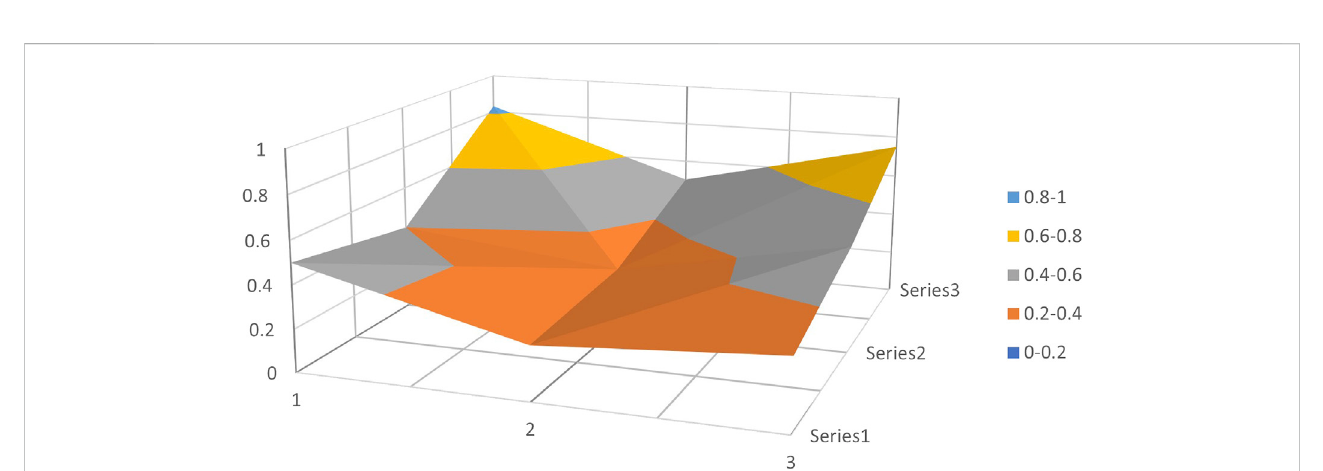
FIGURE 7 PMC surface of P 7 .